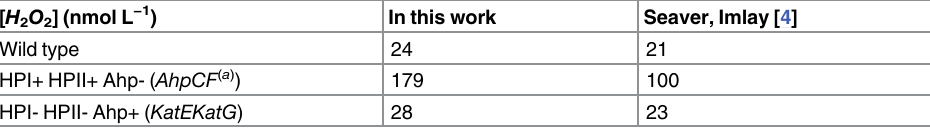
Table 2. H 2 O 2 steady-state concentration.